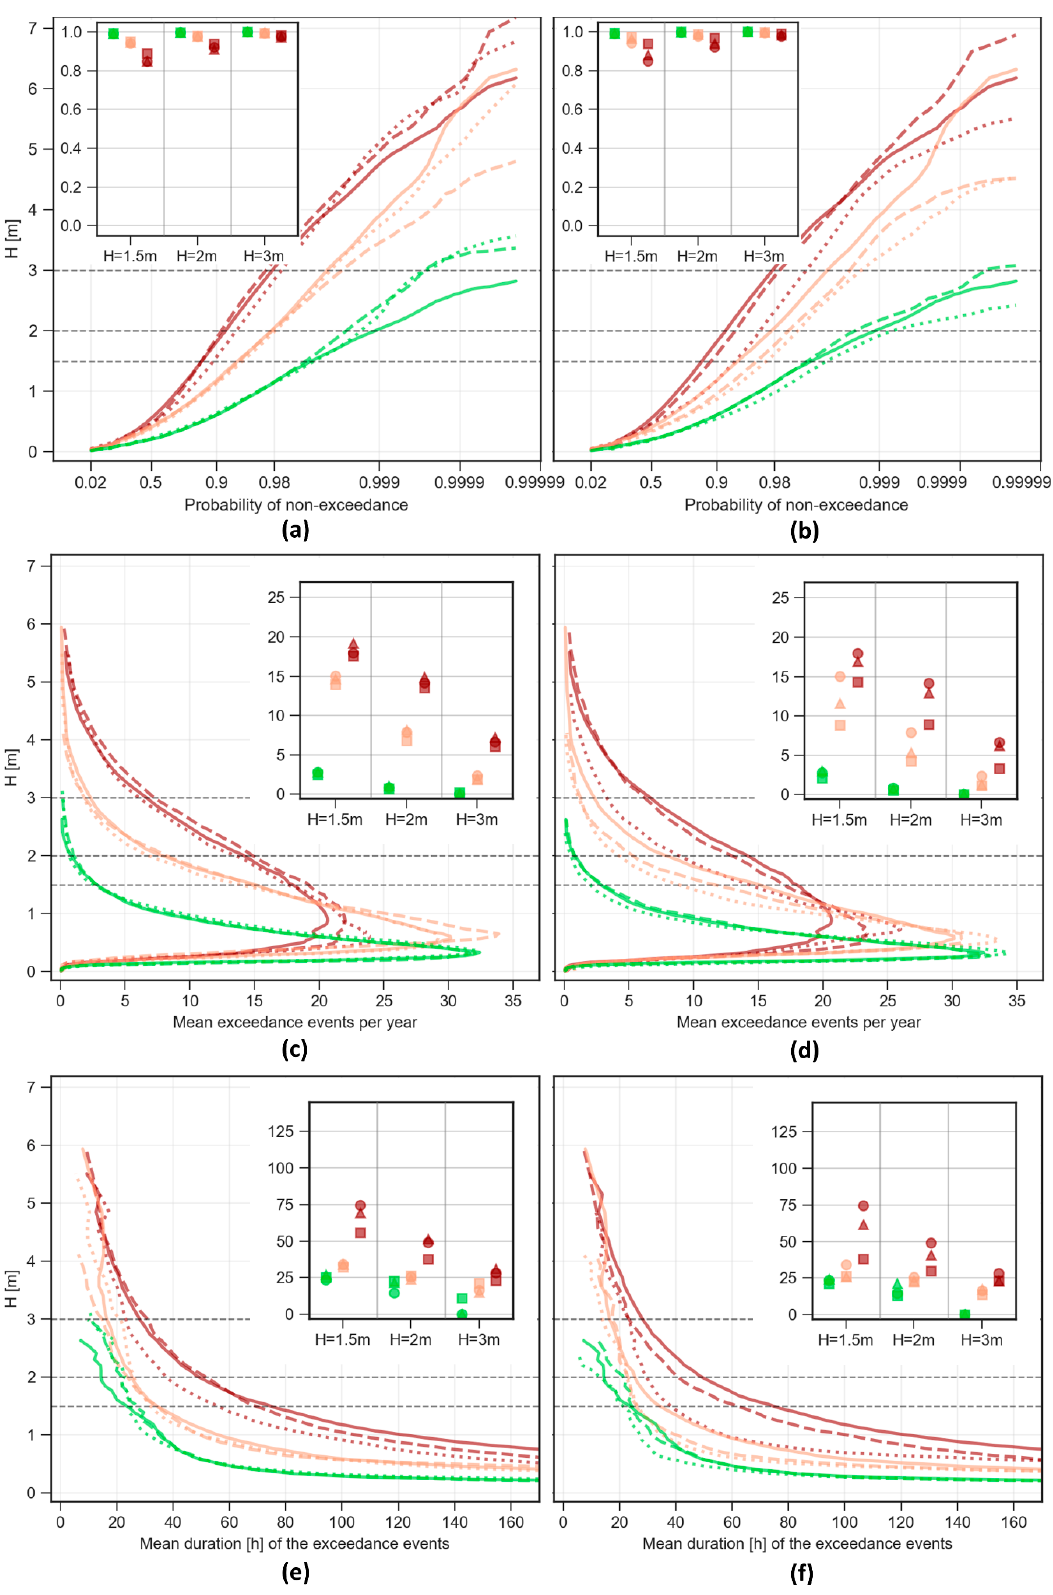
Figure A8. Comparative of operability indicators for Type 4 AOIs, including a detail of a threshold overcoming analysis for the complete sets of: ( a ) PROB , short-term; ( b ) PROB , long-term; ( c ) N , short-term; ( d ) N , long-term; ( e ) T , short-term; ( f ) T , long-term.